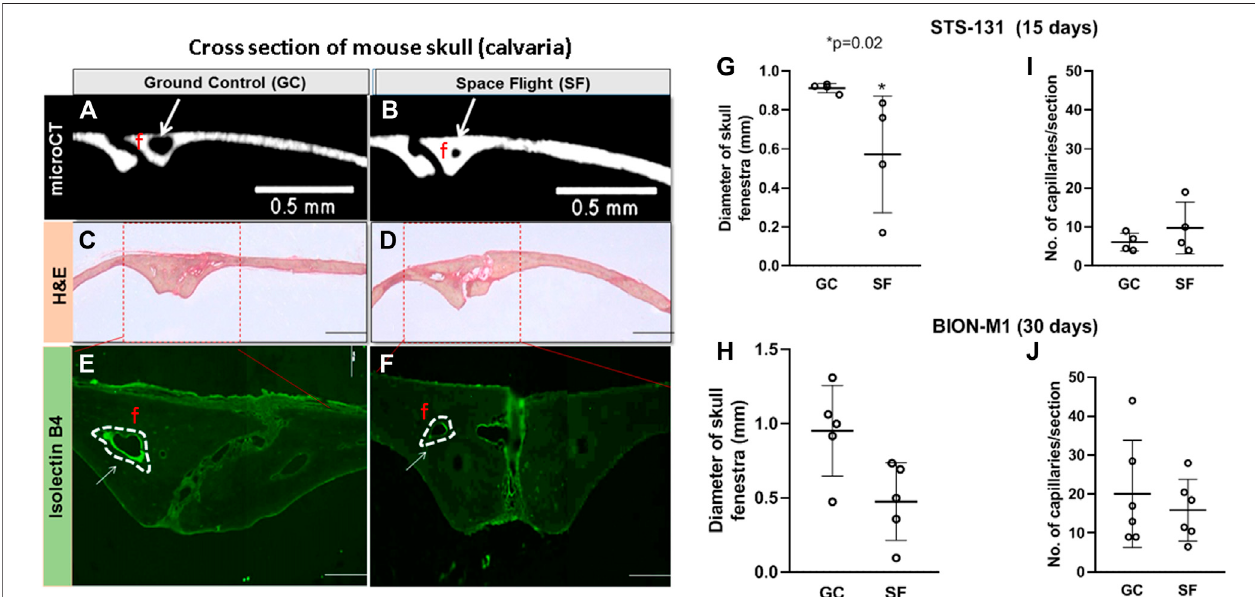
FIGURE 2 | Vascular number and parasagittal capillary size in GC and SF mice calvaria (A,B) Coronal sections of μ CT images of two parietal plate structures and bone marrow cavities in the midline ofthe calvaria. The blood vessels (BV) and the edge of the bone plates in the GC and SF mice are shown. The arrows are pointing to the sizeofthefenestrae (C,D) Eosinhematoxylinstainingofthefrontal section oftheparietal region showing twolarge venules, arteriole,numerous foci, and cellnucleus within the suture surrounded by loose connective tissue (E,F) Isolectin-IB4 staining of the parietal sections of the mice calvaria; labeling of both large and small vessels is shown with a dotted white line (G – J) Measurements of isolectin-IB4-stained blood vessel diameter and capillary number performed on ≥ 15 – 20 microscope imagesperslidesection(n=2sections/slide)foratotalofeightSTS-131 miceexposedto15 daysmicrogravity(GC, n=4;SF,n=4)and10BION-M1miceexposedto 30 days of microgravity (GC, n = 5; SF, n = 5). The values are expressed in mm. The data are represented asmean ± SE, * p = 0.02. The images were obtained with a4x objective lens and depict fenestrae containing calvarial vessels. Scale bar is 2 mm and the width of the section is 2